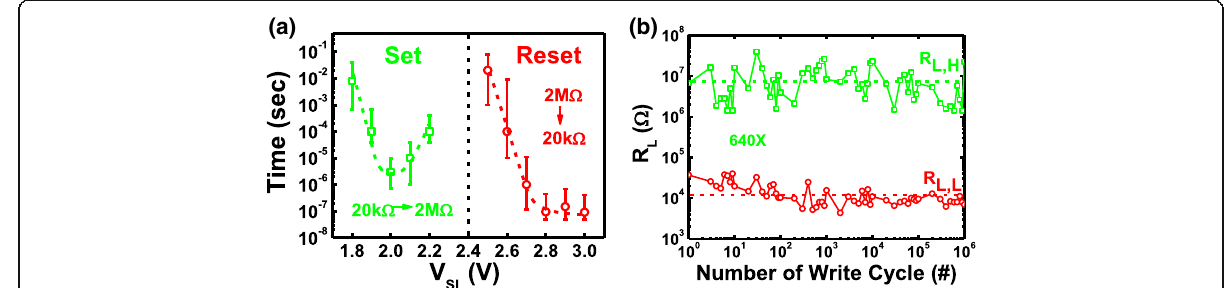
Fig. 4 a Summarized time-to-set and time-to-reset vs. V PP . b One million cycles endurance test result of the STI-RRAM using Incremental Step Pulse Programming algorithm